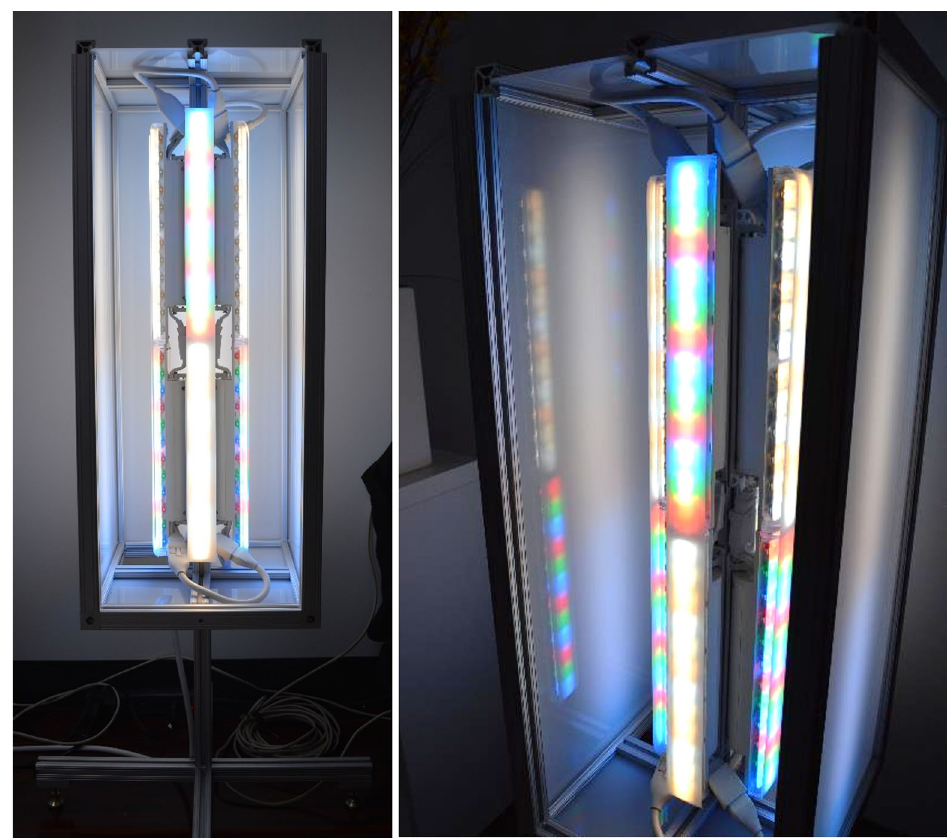
Figure 3. Typical luminaire assembly consisted of a series of Philips Powercore fixtures arranged around a central post and enclosed in a housing constructed of an aluminum frame with frosted acrylic panel inserts. Acrylic panels were used to blend the individual LEDs. For further diffusion, three individual strips of vellum were applied to the surface of each fixture.